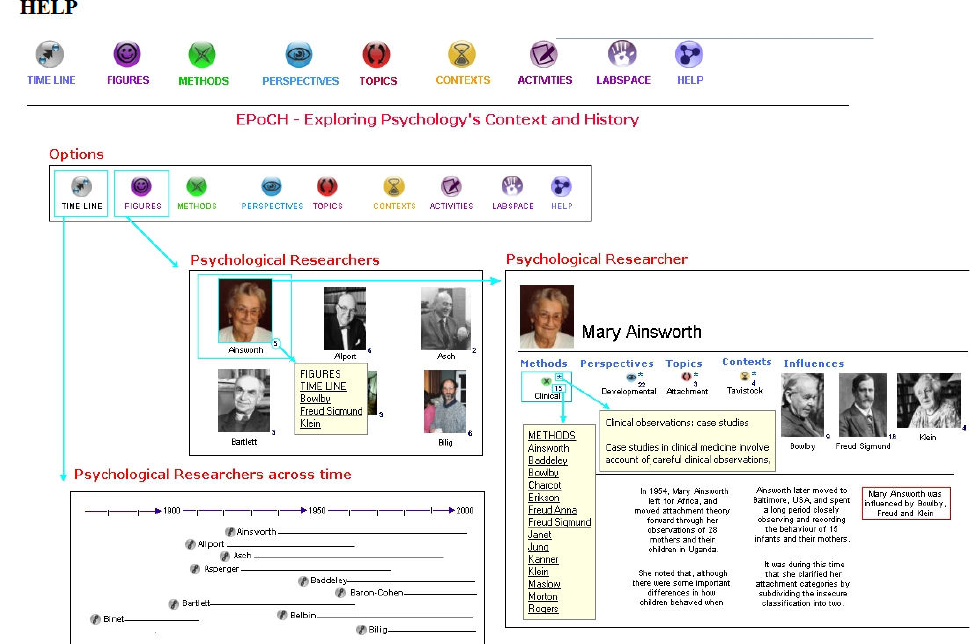
Figure 11 . EPoCH delivered as Compendium